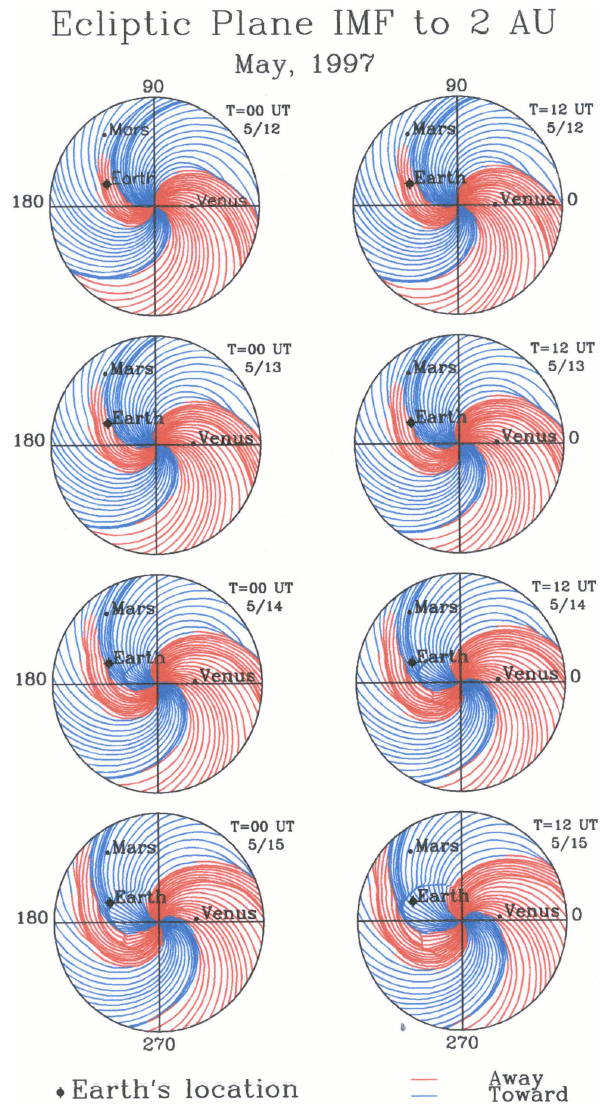
Fig. 3. Ecliptic plane simulation by the HAFv.2 model of the tem- poral IMF disturbance caused by the shock from Event 1 (initiated on 12 May 1997). Polarity is indicated by blue (toward the Sun) and by red (away). The location of the Earth is indicated by a large black dot; of Venus and Mars, by smaller